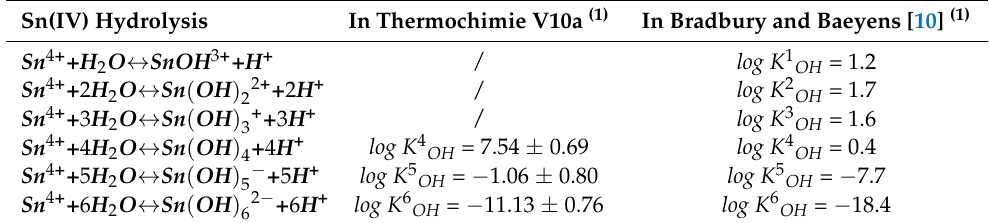
Table 4. Sn(IV) hydrolysis reactions and constants implemented in Thermochimie V10a database and derived from Gamsjäger et al. [5] compared to constant values used by Bradbury and Baeyens [10]. Sn(IV) Hydrolysis In Thermochimie V10a (1) In Bradbury and Baeyens [10] (1) log K 1 OH =